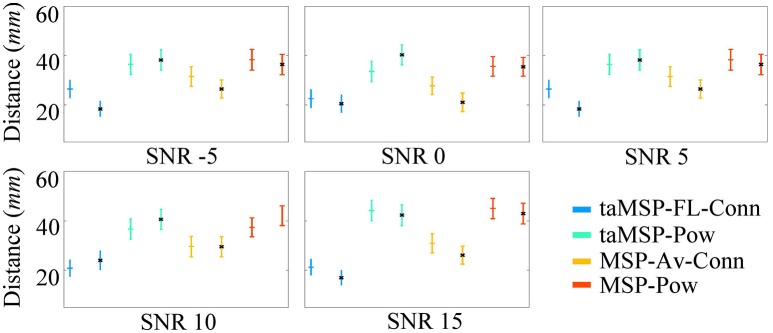
Precision of the tested methodologies of SOZ location under several levels of noise, and avoiding the inverse crime. The corresponding color marker for each scenario (i.e., blue for taMSP-FL-Conn) indicates the model with 32 channels, and the black marker (*) indicates the model with 128 channels.